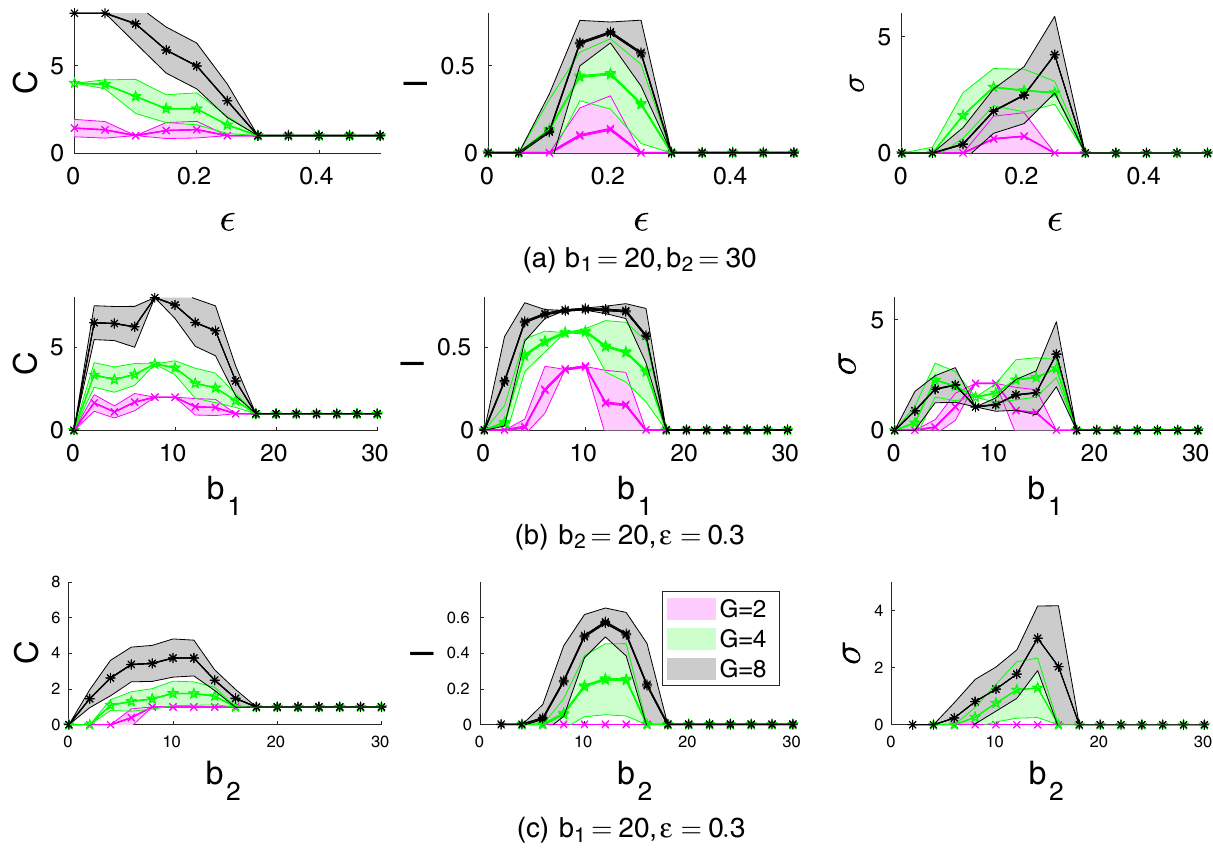
Figure 4. Effects of ( a ) the incumbency parameter ε ; ( b ) the benefit parameter b 1 ; and ( c ) the benefit parameter b 2 on the number of cooperating groups C , the Gini index of inequality I , and standard deviation of efforts σ among them for different number of groups G . Groups of the same size n = 10 are considered. The shaded areas shows the corresponding confidence intervals. Other parameters: α = 1 , c = 1 , π 0 = 1 , X 0 = 5, Z 0 = 50 , µ 1 = µ 2 = 0.25 . The figures show the averages and confidence intervals based on 100 runs each of 4000 time steps for each parameter combination. Results in each run are averages based on the last 1000 of time